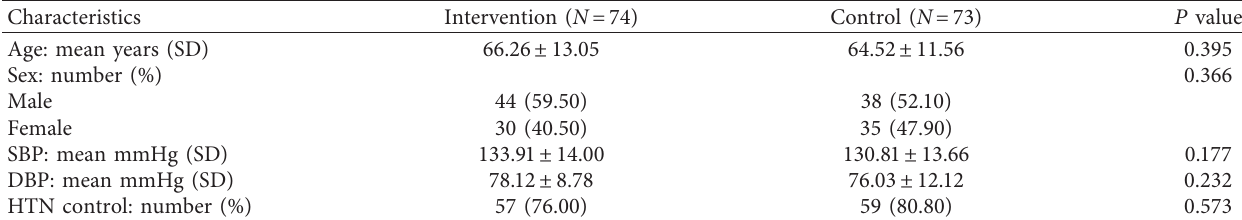
Table 1: The baseline characteristics of intervention and control groups. Characteristics